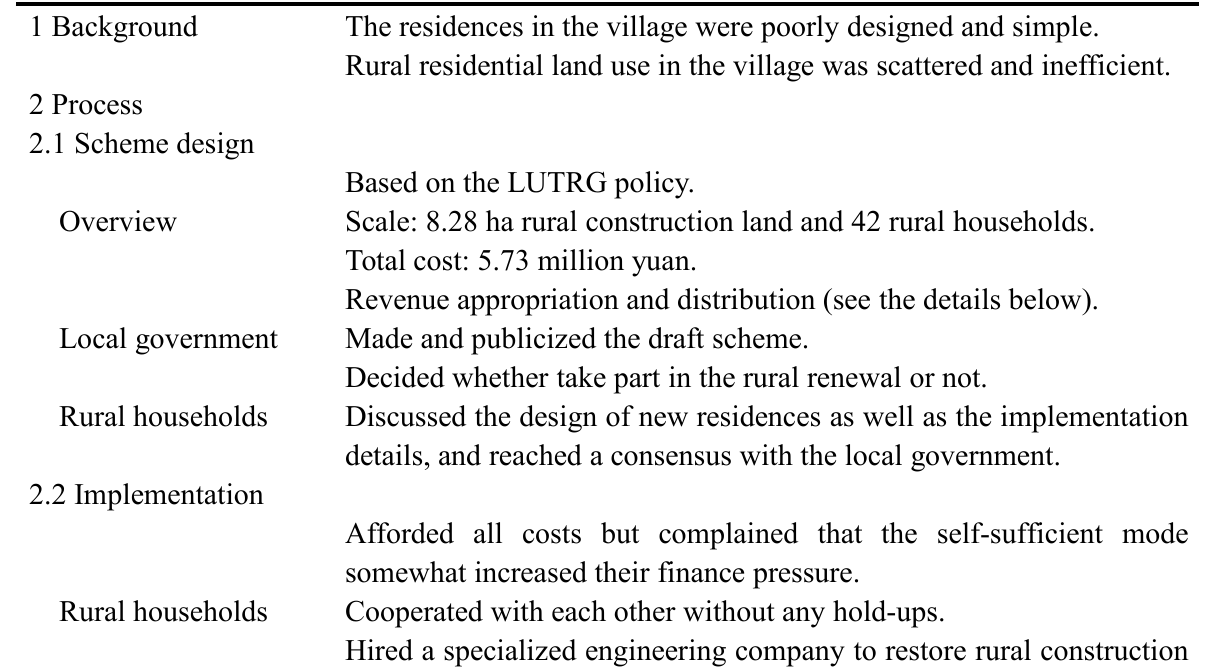
Table A3.2: Archetype 2 Small-scale rural renewal with sufficient stakeholder participation